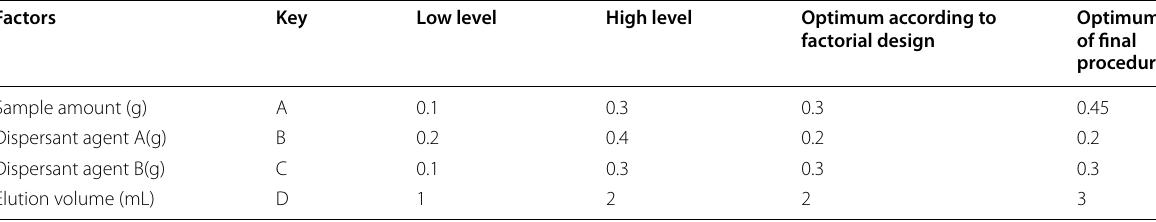
Optimal values for phthalates determination